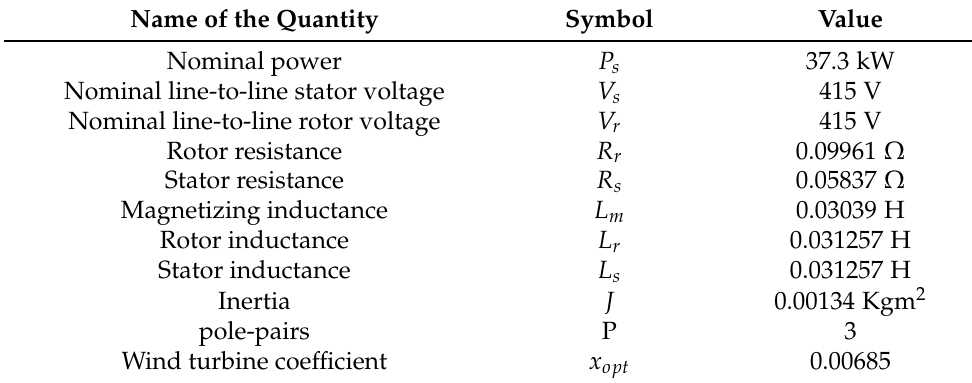
Table 1. DFIG parameters [6].